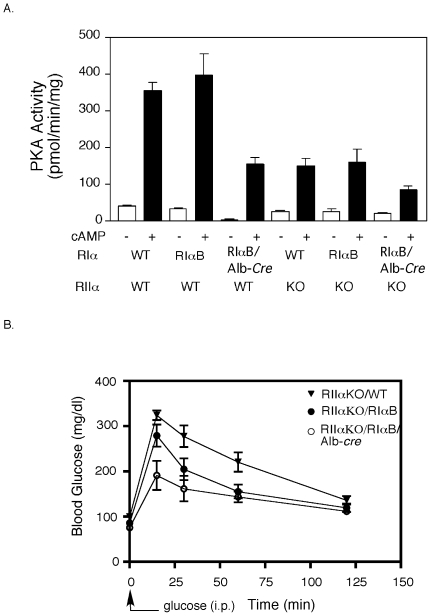
RIαB/Alb-cre mice and RIαB mice on the RIIα KO background exhibit increases in glucose disposal.
A, Representative kinase assay of basal and total kinase activity in WT, RIαB, RIαB/Alb-Cre,RIIαKO, RIαB:RIIαKO, and RIαB/Alb-Cre:RIIαKO liver. All samples were done in triplicate in the absence (basal) or presence (total) of 5 µΜ cAMP using Kemptide as substrate. Kinase activity that was not PKA-specific was measured in the presence of PKI and subtracted from basal and total values. Data values are represented as mean ± SEM. At least three mice from each genotype were used for the kinase assay. B, Glucose tolerance tests on 24 hr fasted WT, RIαB and RIαB/Alb-Cre mice all crossed onto the RIIα KO background are shown. Two mg of glucose per gram of body weight was injected i.p. and blood glucose levels were determined at the indicated time points. Values are presented as means ± SEM. n = 5. Glucose levels in RIαB/Alb-cre animals were significantly reduced compared to WT and RIαB during the first 30 min. P<0.01.